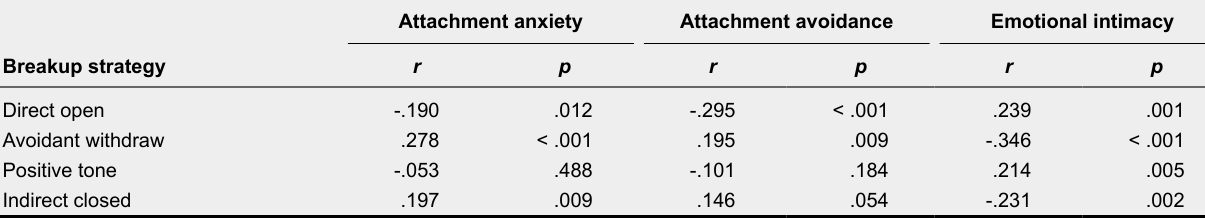
Attachment anxiety